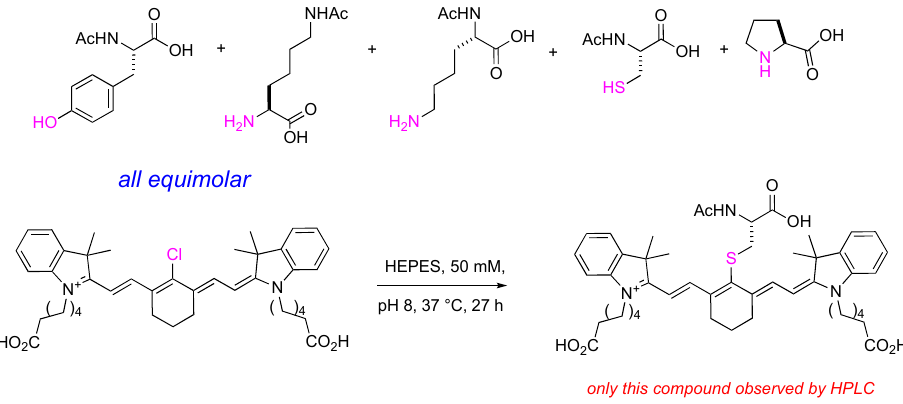
Scheme 2. Competition study of MHI-148 with amino acids in aqueous buffer.